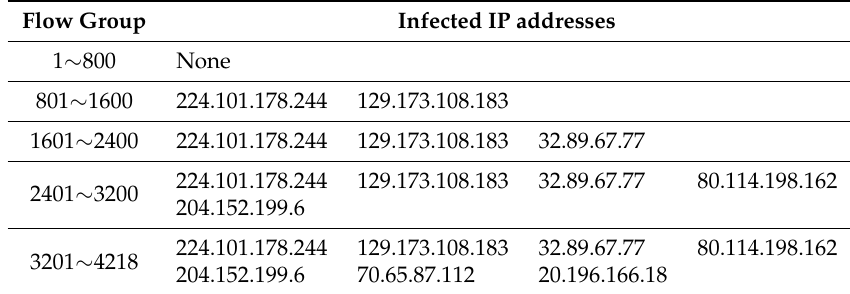
Infected IP addresses in the dataset for each flow group under a polyworm simulation